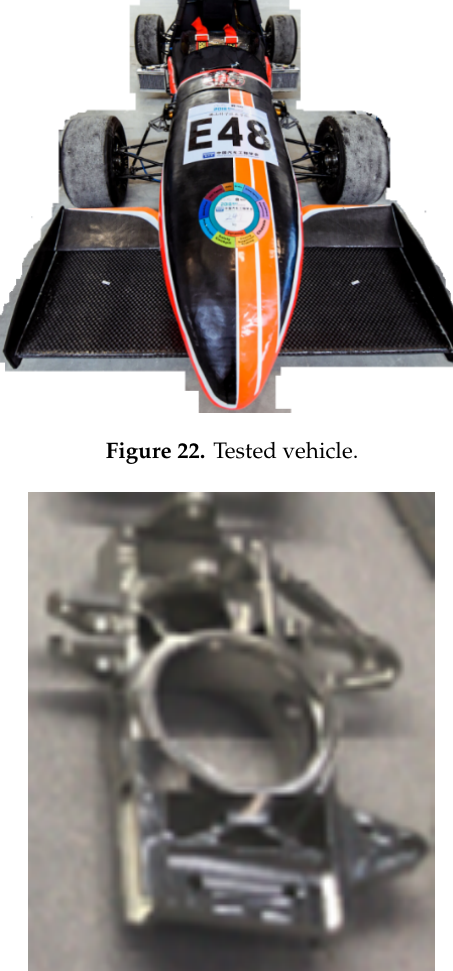
Figure 23. The front upright disassembled after the test.